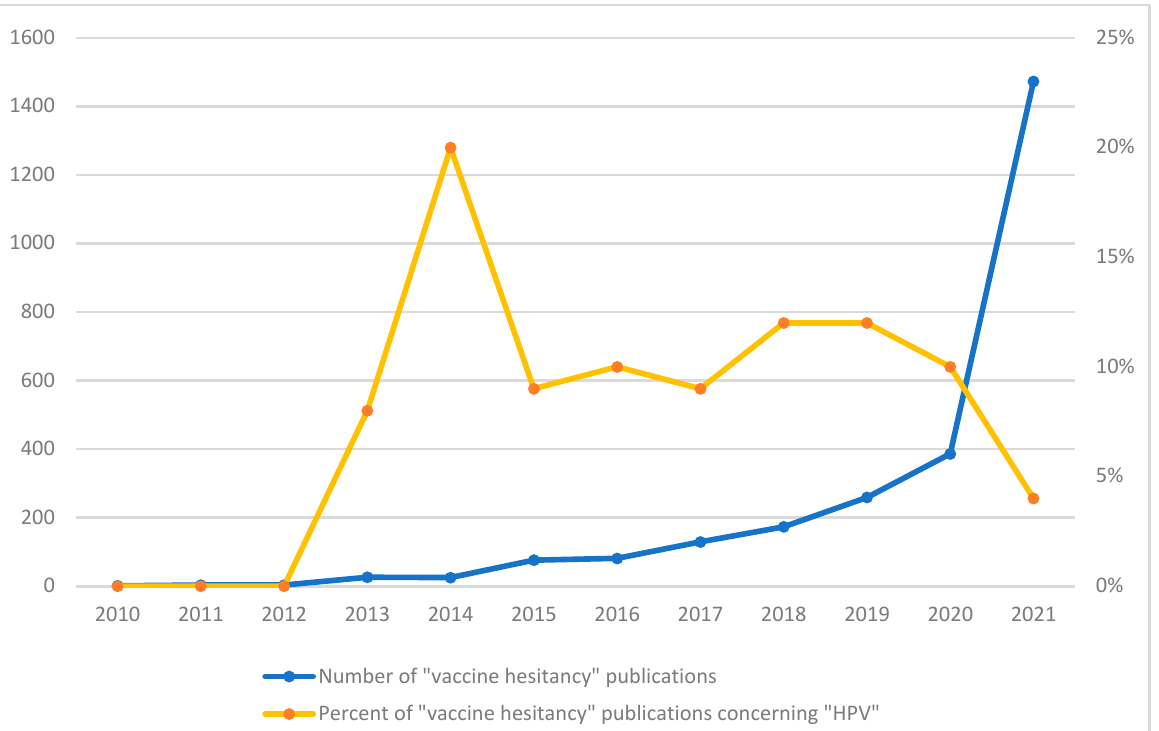
Figure 1. Number of vaccine hesitancy publications by year, and percent concerning HPV. Note . This figure was modified from previous work by the author [98]. Pubmed was searched for articles published between 2010 and 2021 using the term “vaccine hesitancy”, and the number of papers is plotted against the year (in blue, see left y-axis). A separate search in Pubmed over the same time was conducted using the terms “vaccine hesitancy” AND “HPV”; the percent of “vaccine hesitancy” papers concerning “HPV” was calculated (in orange, see right y-axis).